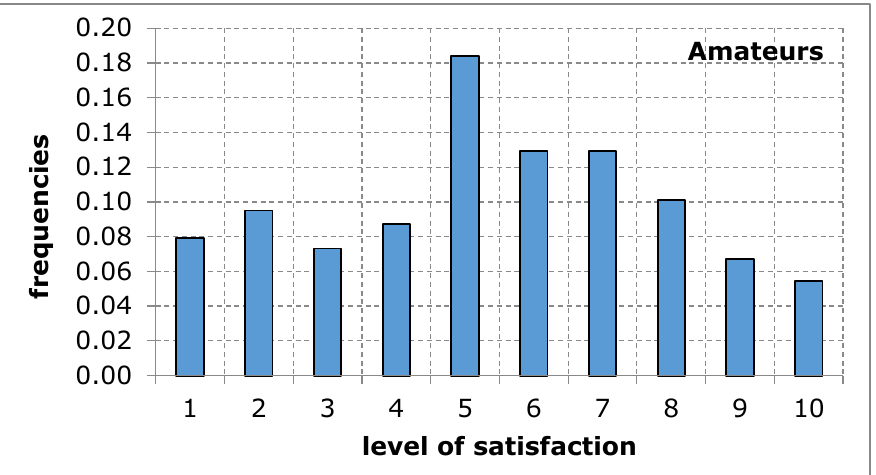
Figure 3. A sports and recreation facility is too far away, in the opinion of service recipients (amateurs). Source: own work.